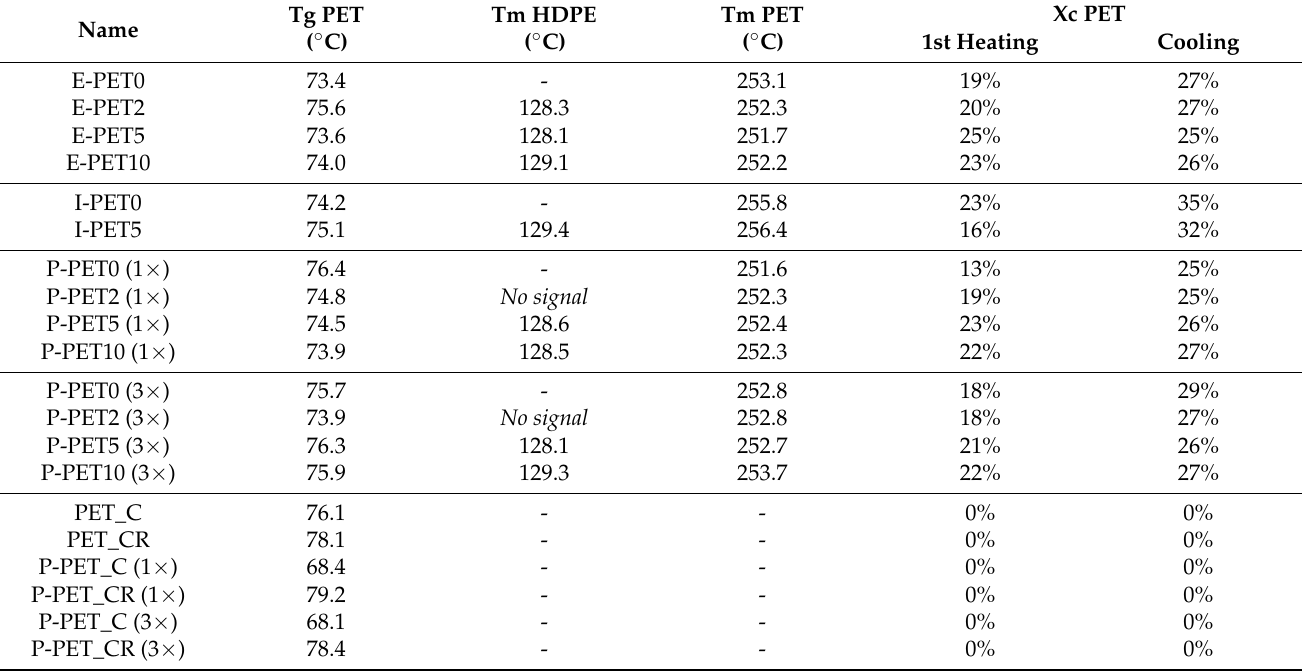
Table 4. Glass transition Tg, and melting point Tm, of HDPE and PET and crystallinity of PET in blends. Single prints are indicated as ‘1 x ’ and three prints as ‘3 x ’, respe ctively.